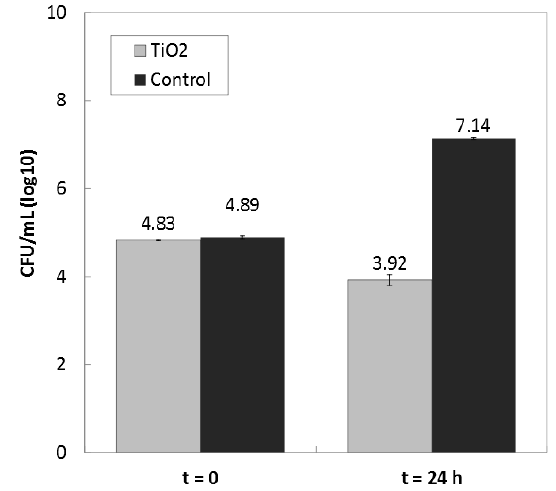
Figure 2. Bacterial concentration after 24 h with TiO n = 3.